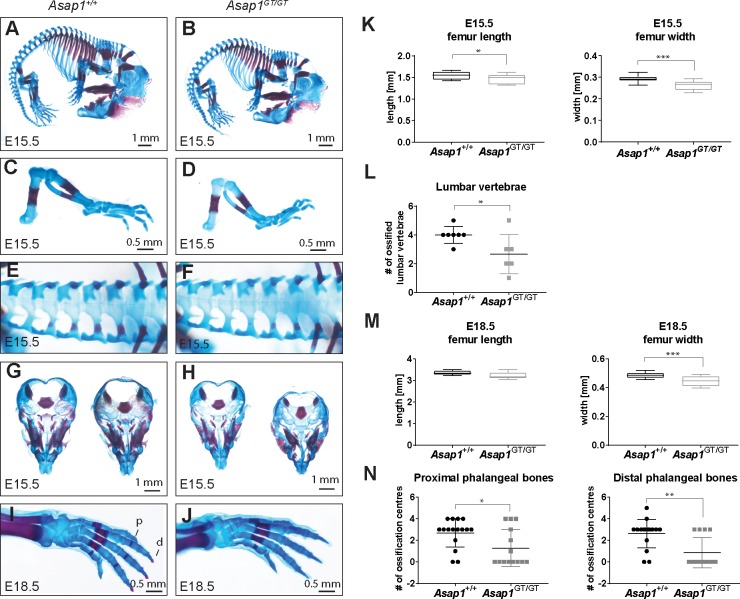
Loss of ASAP1 delays ossification.(A-H) Chondroskeletal staining of E15.5 Asap1+/+ (A, C, E, G) and Asap1GT/GT embryos (B, D, F, H), demonstrating reduced whole body size (A, B) and reduced size and ossification of hind limbs (C, D), lumbar vertebra (E, F) and skull (G, H) in Asap1GT/GT embryos. (I, J) Chondroskeletal staining of E18.5 embryos, demonstrating reduced ossification of proximal and distal phalangeal bones in Asap1GT/GT embryos. (K, L) Quantification of femur length, width and number of ossified lumbar vertebrae in E15.5 embryos (Asap1+/+ n = 7, Asap1GT/GT n = 6). (M, N) Quantification of femur length and width (Asap1+/+ n = 5, Asap1GT/GT n = 5) and the number of proximal and distal ossification centers in E18.5 embryos (Asap1+/+ n = 8, Asap1GT/GT n = 8, left and right). For K and M, the box-whisker plots show the mean values and the 25th and 75th percentiles ± SD. For L and N, graphs show the mean ± SD. Significance was calculated using the Student’s t-test*, p < 0.05, ** p < 0.005, *** p < 0.001. p, proximal; d, distal.